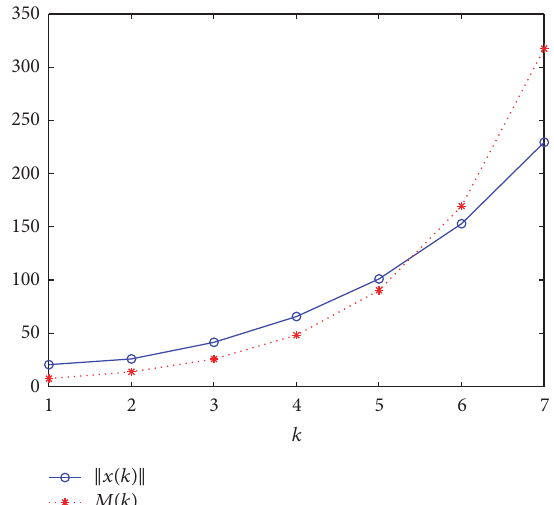
Figure 1: Selection of 𝑘 0 .